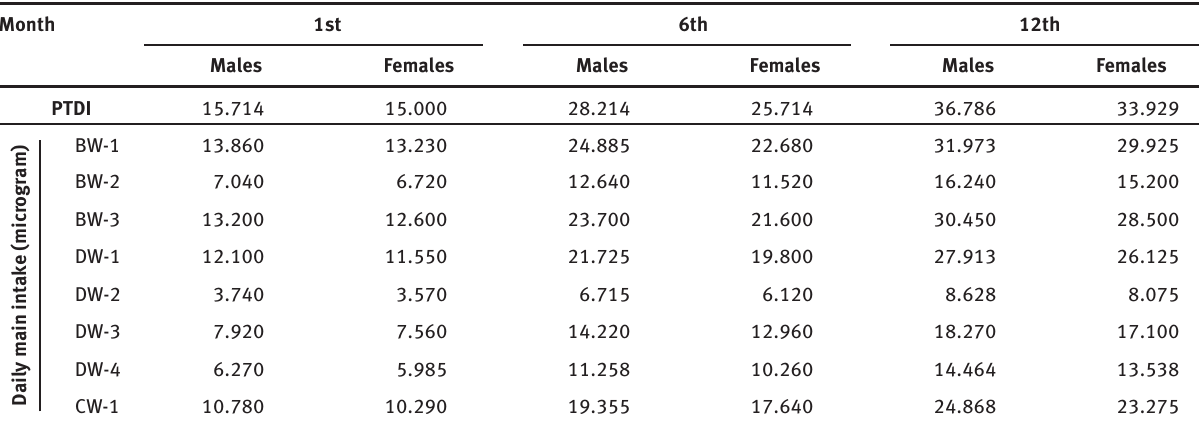
Table 5: Daily main intake values of Pb based on gender and age of infants Month 1st